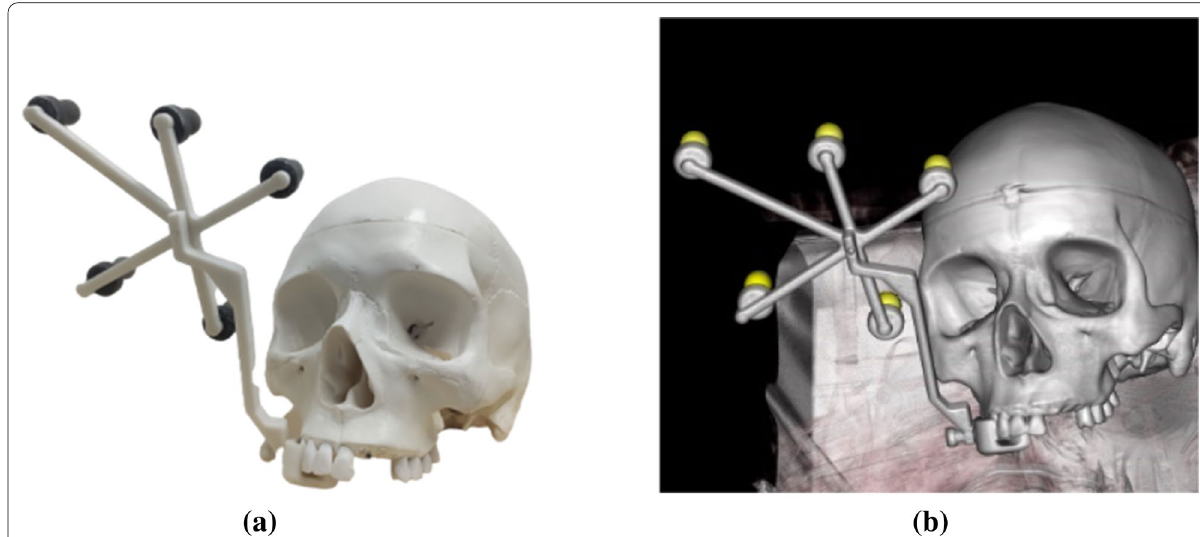
Figure 5 a Skull model in actual surgical space, b Skull model in image